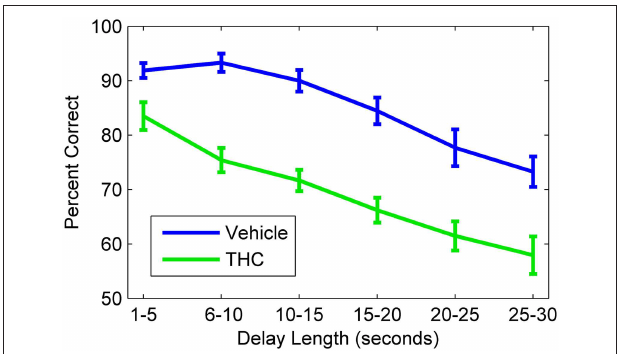
FIGURE 3 | Delayed nonmatch-to-sample behavioral performance during vehicle and tetrahydrocannabinol (THC) sessions. Mean correct nonmatch responses summed across all rats ( n = 10 ) shows the delay-dependent decline in performance under both conditions. A within subjects design with at least one non-drug day between THC administration was used. All animals were given THC (1.0–3.0mg/kg) for at least five sessions spaced over consecutive weeks. Error bars indicate